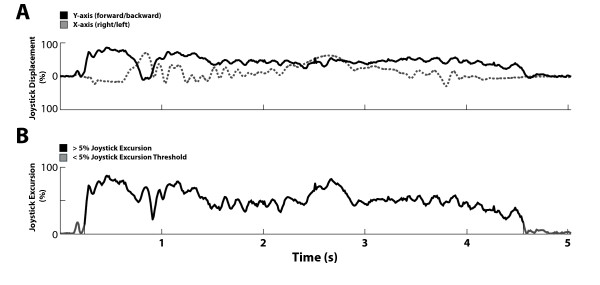
Uniaxial and Biaxial interpretations of joystick displacement and combined excursion for a typical trial. A: Uniaxial × (left/right) and Y (forward/backward) components of joystick displacement from the central resting position plotted over time during a single trial from the Turns 90° While Moving Forward. B: Biaxial (x and y components combined) representation for joystick excursions for the same trial.